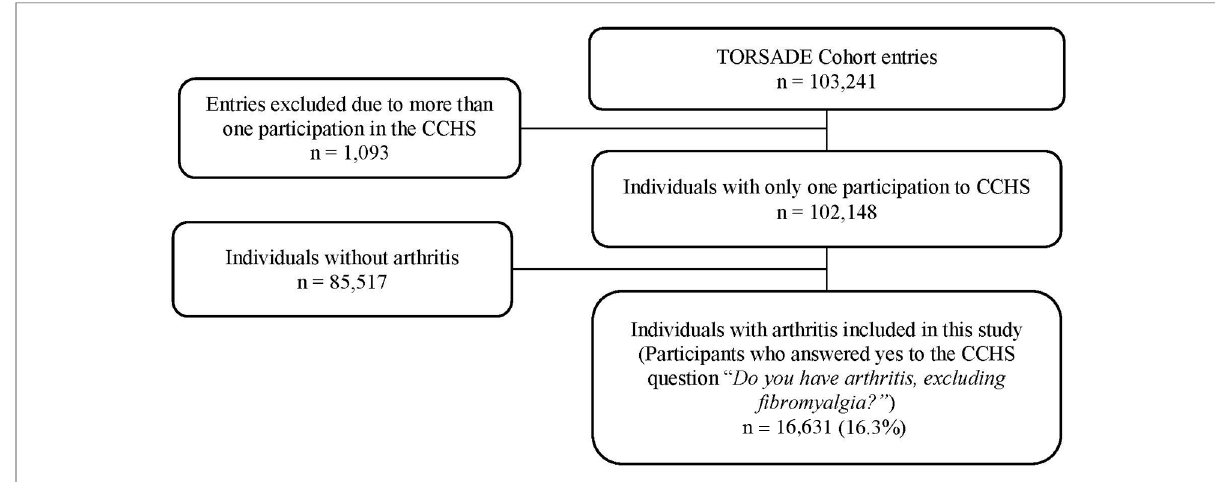
FIGURE 1 Study sample